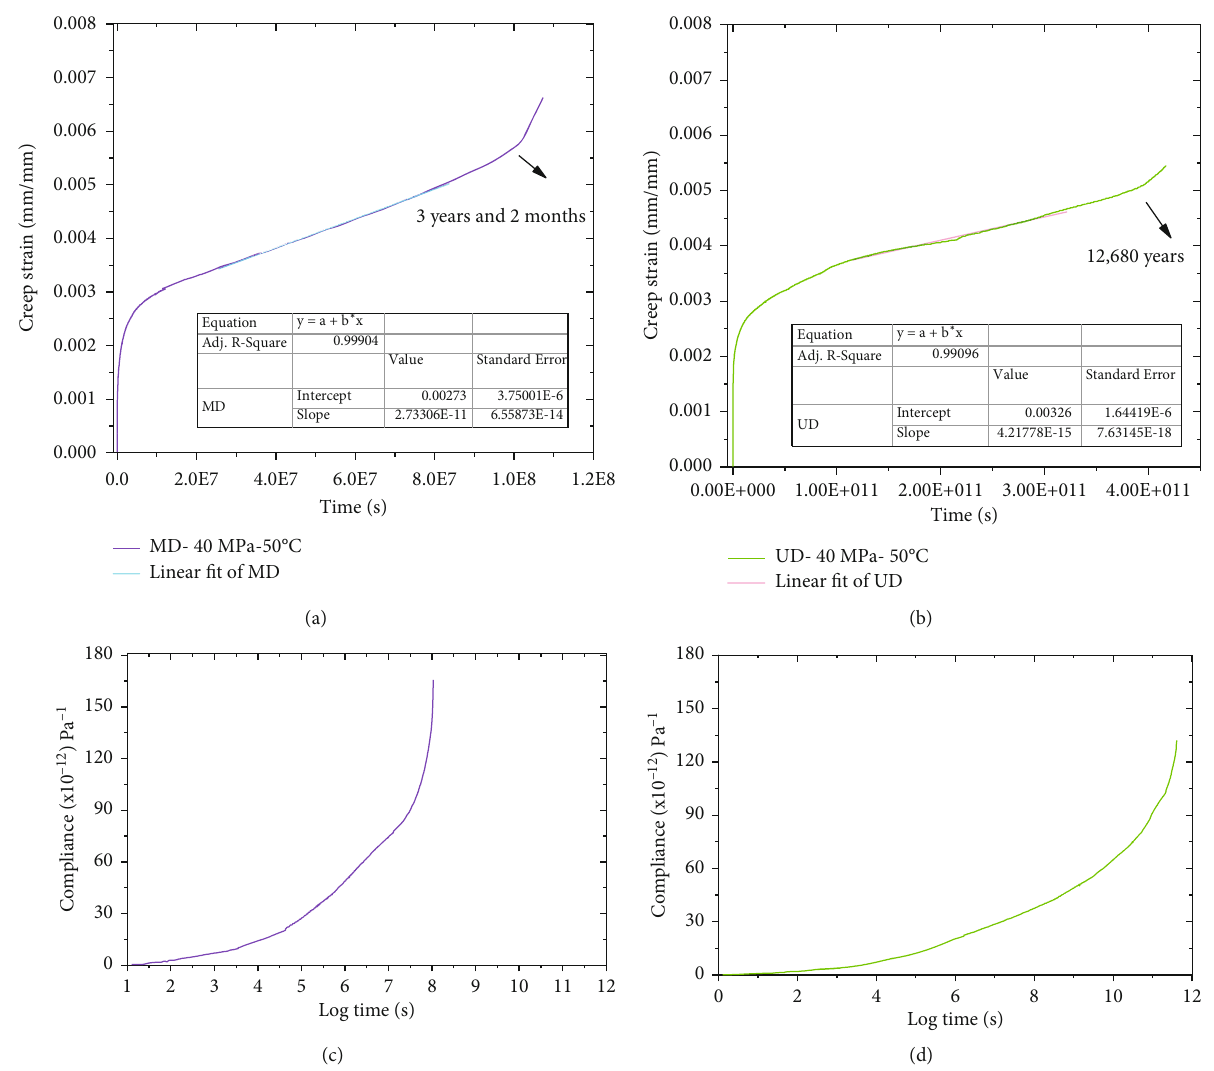
Figure 9: Stacking sequence e ff ect on (a) creep strain and (c) compliance for the MD composites and the e ff ect on the (b) creep strain and (d) compliance for the UD composites, near the glass transition temperature (50 ° C) and at